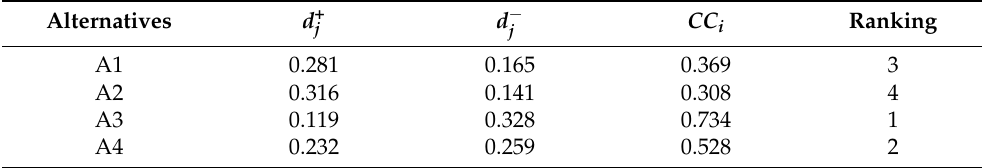
Table 10. Closeness coefficients among different fall protection plan